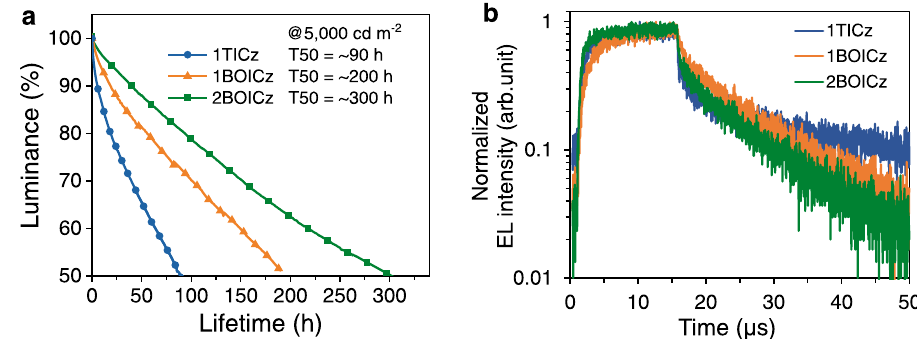
Fig.4|StabilityandELtransientcharacteristicsofTADFdevices.a Theoperationallifetimesofthedevices,and b ELtransientspectraofdevicesbased1TICz,1BOICz, and